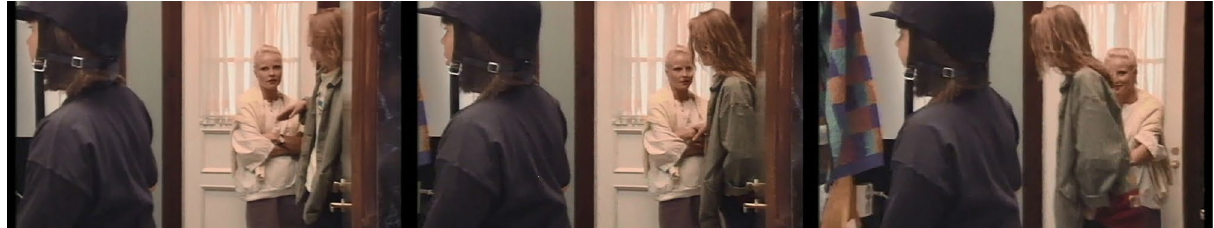
Figure 5. Non-verbal gesture- and gaze-based communication during the events (2) in the video clip 4 (picture published with the permission of Finnish commercial media operator